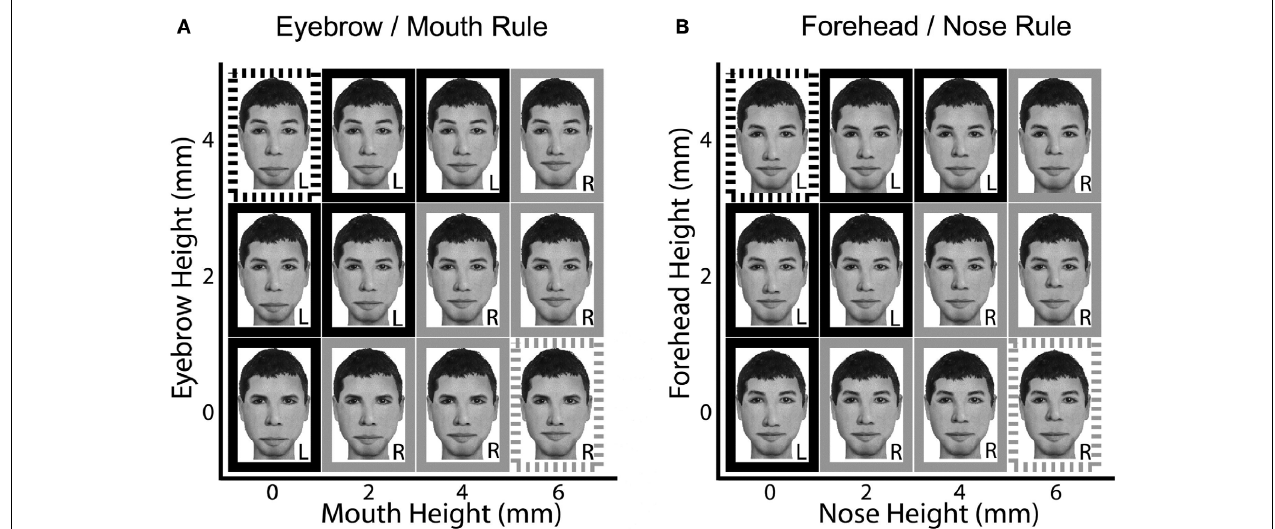
of 12 faces: 6 faces were assigned to a left button press and 6 to a right button press. Only 10 faces were used during training (shown surrounded by thick borders). During scanning, two new faces were introduced for each task (shown surrounded by dashed